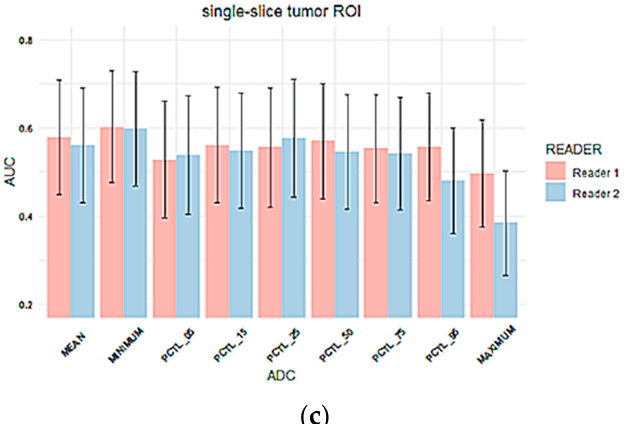
Figure 5. Column plots of AUC values for percentage change in tumor ADC metrics for ( a ) multiple-slice restricted ROI, ( b ) single-slice restricted ROI and ( c ) single-slice tumor ROI. In each plot, the x-axis lists mean ADC and histogram parameters of ADC values within the ROI (minimum, 5th percentile, 15th percentile, 25th percentile, 50th percentile, 75th percentile, 95th percentile, maximum), and the y-axis represents estimated AUC values. Colors represent readers. (Pink: reader 1, blue: reader 2). Error bar is 95% CI. PCTL = percentile.